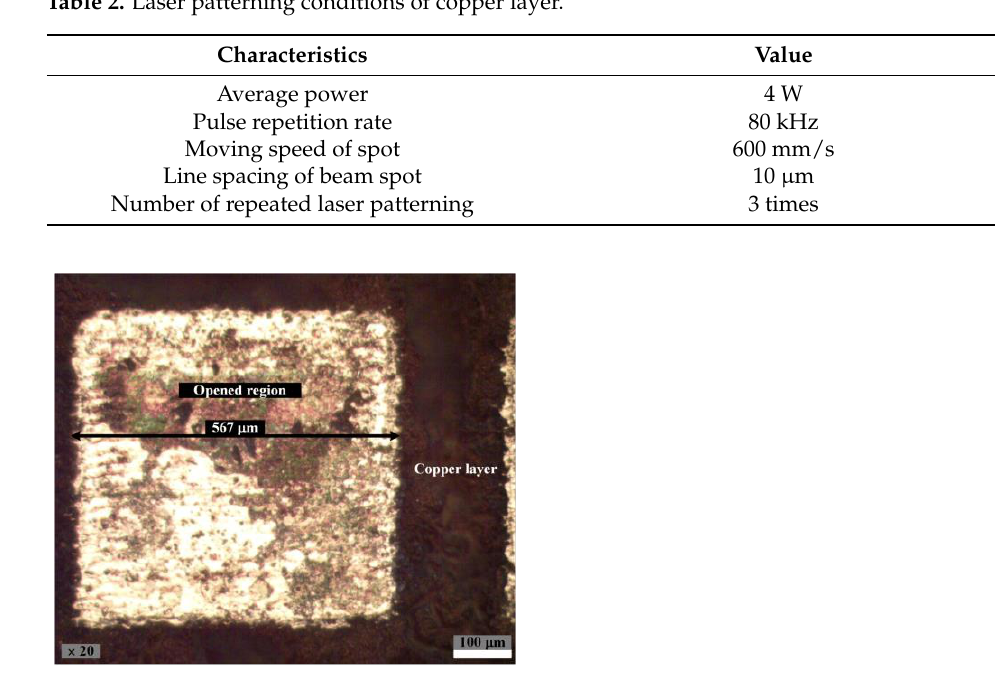
Figure 3. Optical image of laser-patterned copper layer. Table 2. Laser patterning conditions of copper layer.